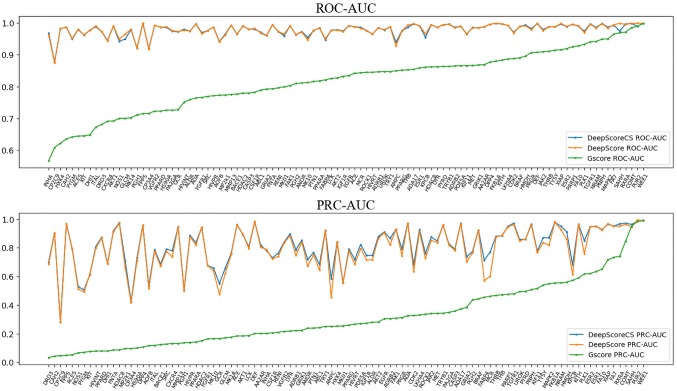
ROC-AUC (upper panel) and PRC-AUC (lower panel) of cross validation performance on each target. Targets are sorted by the performance of Gscore.